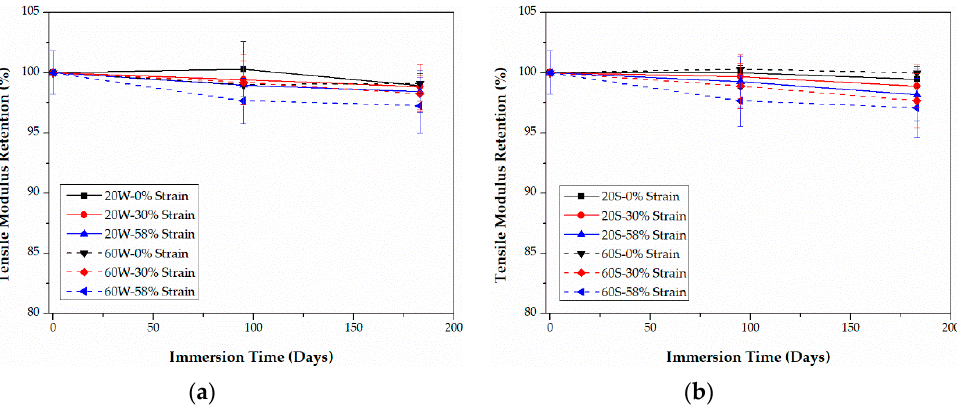
Figure 12. Retention of the tensile modulus of PU-based CFRPs immersed in distilled water ( a ) and seawater ( b ) for 6 months, respectively.